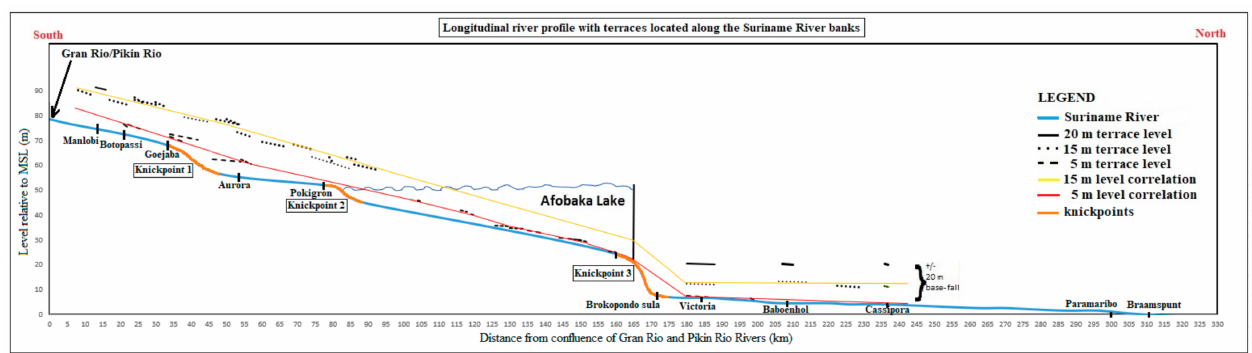
Figure 6. Longitudinal profile of terrace remnants and their correlation along the Suriname River valley. Knickpoints coincide with larger sulas